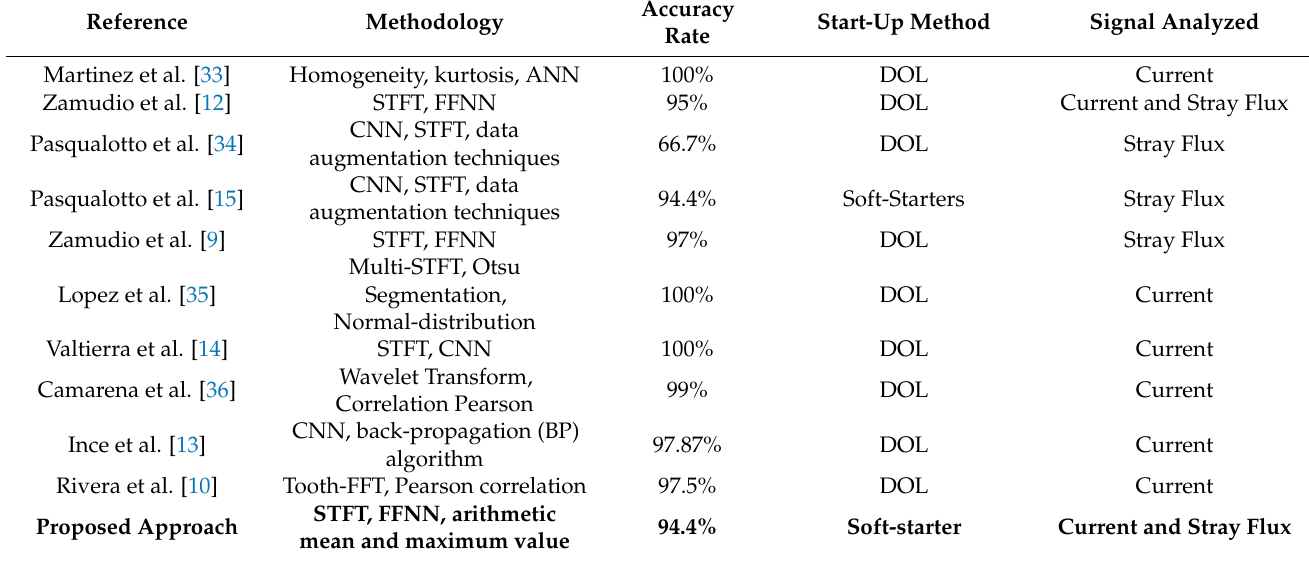
Table 5. Comparison of different methodologies used in literature to detect broken bars in induction